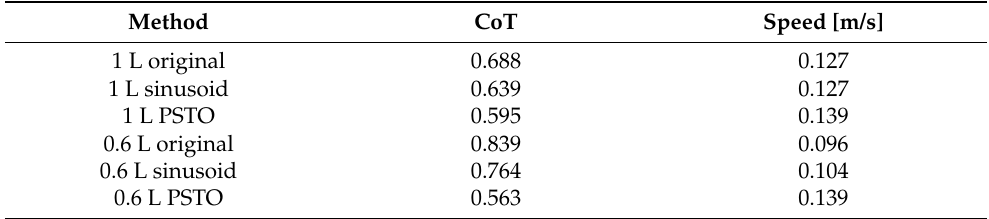
Figure 6. CoT related to amplification for original trajectory, sinusoid trajectory, and PSTO trajectory for 1 L leg length ( top ) and 0.6 L leg length ( bottom ) in the real-world experiments. The amplification range is from 1.0 to 2.4. The curves are the 2nd order polynomial regression for the tendency of three methods. PSTO can achieve lower CoT cost than the other two methods for different amplifications when the leg length is 1 L. For 0.6 L leg length, PSTO has competitive energy efficiency among the three methods when the amplification is low. With the increasing amplification, PSTO can achieve outstanding energy efficiency. Notice that the original trajectory has a larger variance which will exceed the control range of the actuator with a large amplification, so the robot can not conduct the full experiment following the original trajectory. Table 2. Comparisons of original method, sinusoid method and PSTO with 1 L leg length and 0.6 L leg length in the real-world